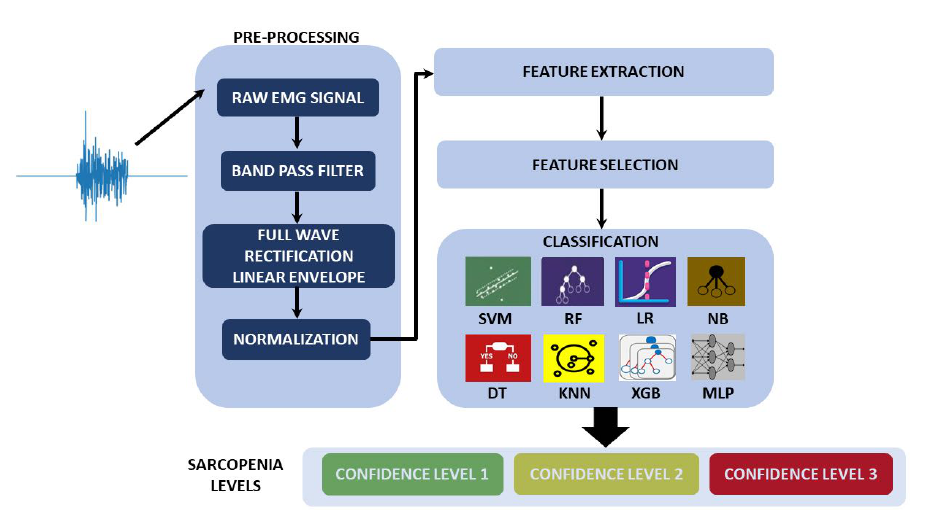
Figure 3. Overview of the proposed algorithmic pipeline designed and implemented for the distinc- tion of different confidence levels of sarcopenia. The pipeline reports within the classification block the supervised classifiers compared in our